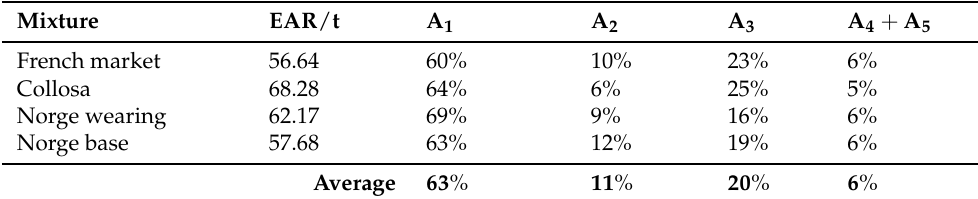
Table 9. Impact due to the different phases of the production process.